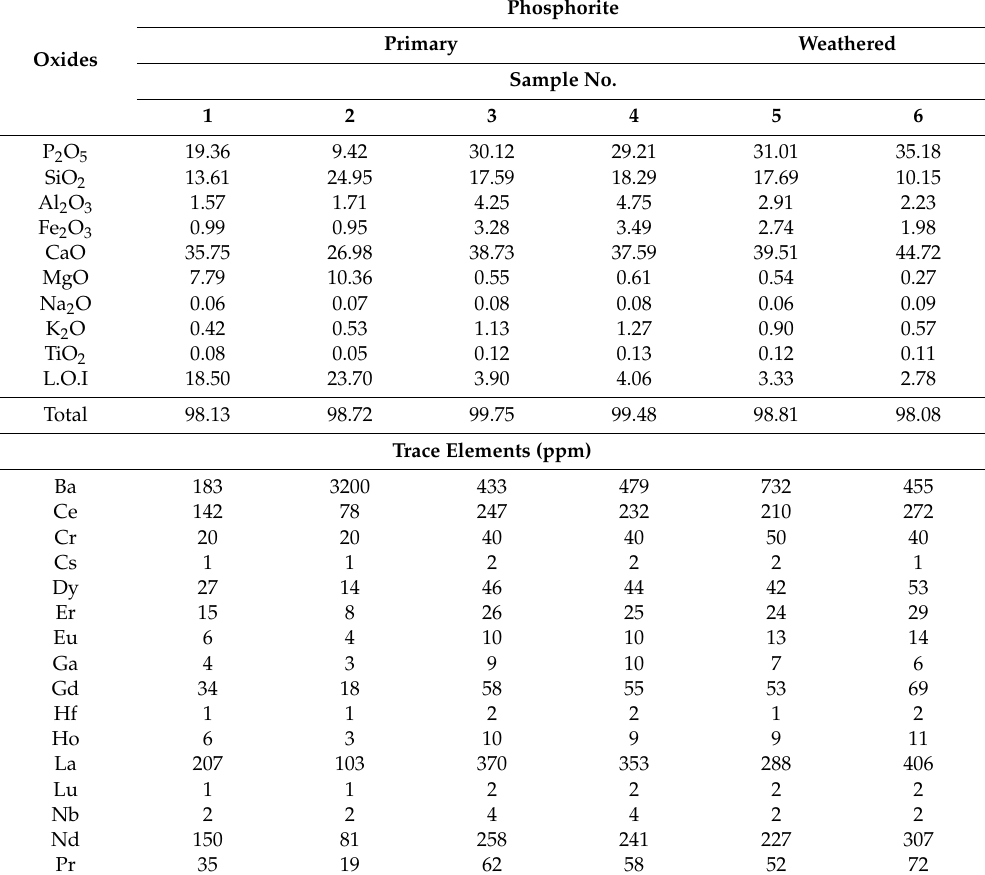
Table 1. Major oxides (%) and trace elements(ppm) of the studied phosphorite samples. Phosphorite Primary Weathered Oxides Sample